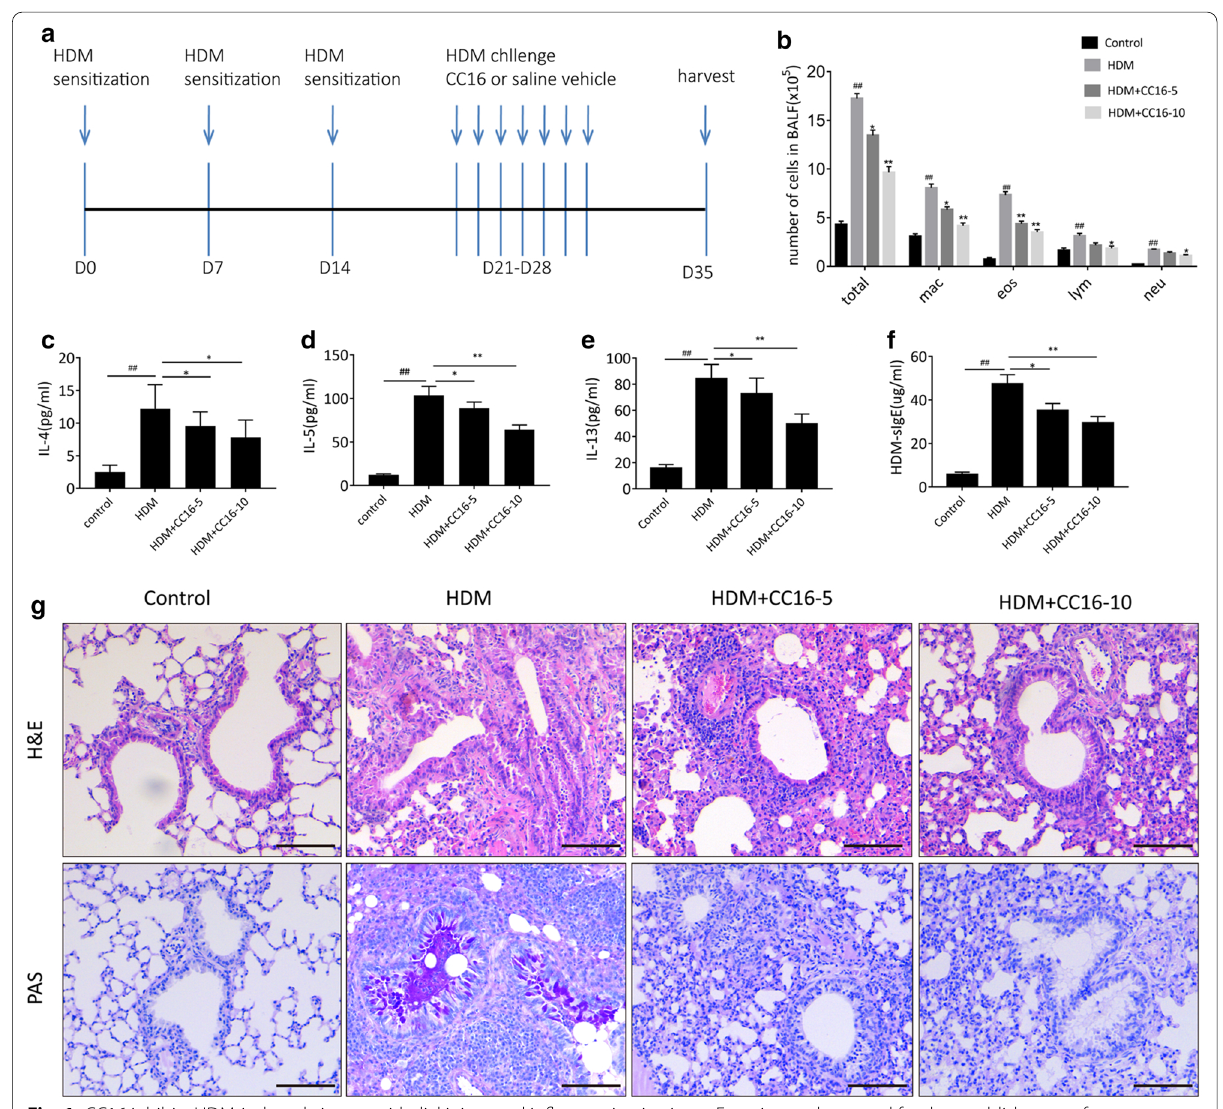
Fig. 1 CC16 inhibits HDM-induced airway epithelial injury and inflammation in vivo. a Experimental protocol for the establishment of HDM-induced murine asthmatic model and treatment with recombinant CC16. b The counts of total and differential inflammatory cells in BALF from control group, HDM group, HDM CC16-5 (treated with 5 ug/g CC16) group, and HDM CC16-10 (treated with 10 ug/g CC16) group by + + Wright staining. c – f The levels of IL-4, IL-5, IL-13 and HDM-sIgE in BALF were measured using ELISA assay. g Representative lung sections from each group were analyzed with H&E or PAS staining. Scale bars 100 μm. Data are expressed as means standard error of the mean (SEM). ## p < 0.01 vs. = ± Control group;*p < 0.05 vs. HDM group; **p < 0.01 vs. HDM